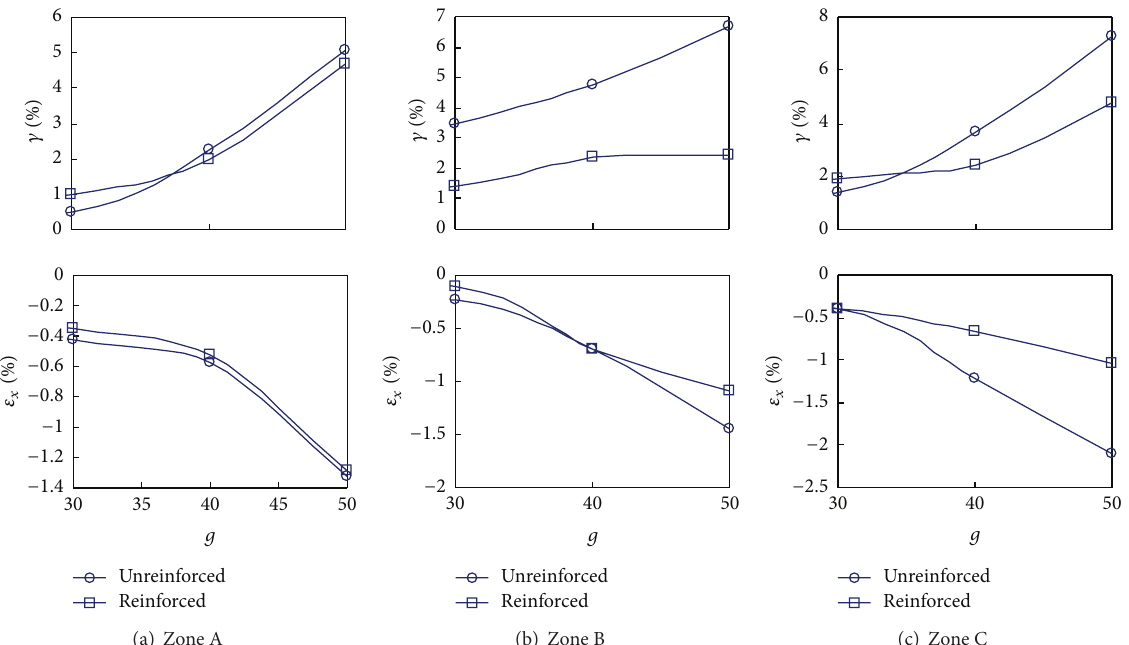
Figure 14: Strain history of typical elements of different zones by test observation. 𝛾 : slope-direction shear strain; 𝜀 𝑥 : horizontal compression strain; g : g-level.